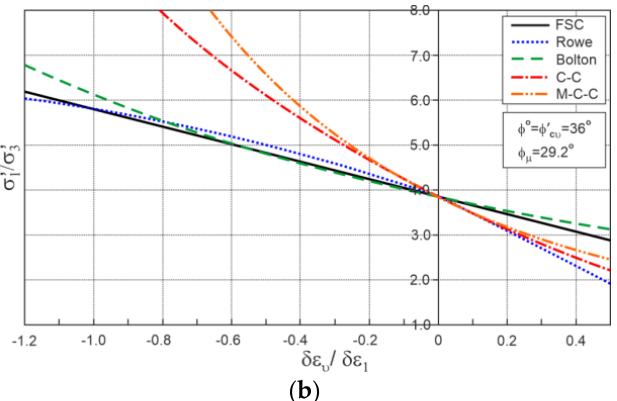
Figure1. Therelationshipsbetweenthestressratioandstrainratioforsandatfailure: ( a ) φ ◦ = φ (cid:48) c υ = 30 ◦ ; ( b ) φ ◦ = φ (cid:48) c υ = 36 ◦ .